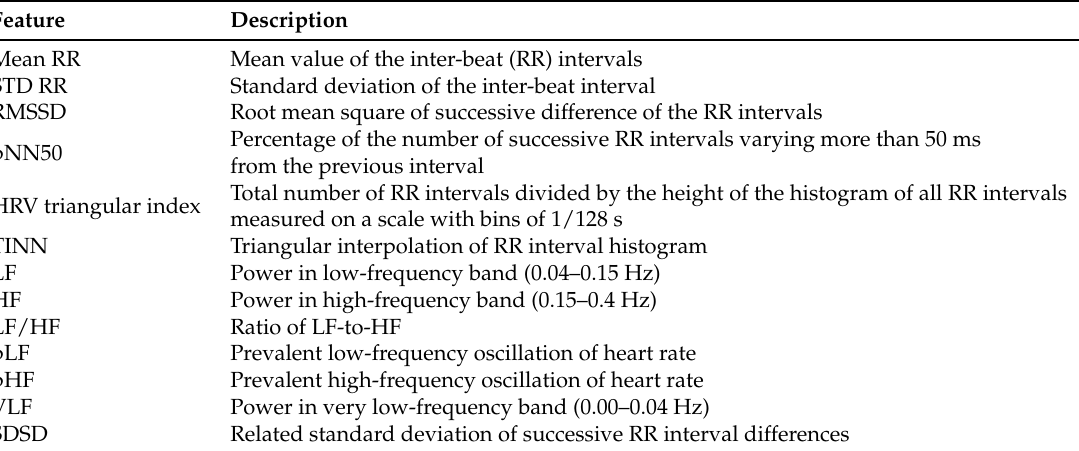
Table 2. Heart rate variability features and their